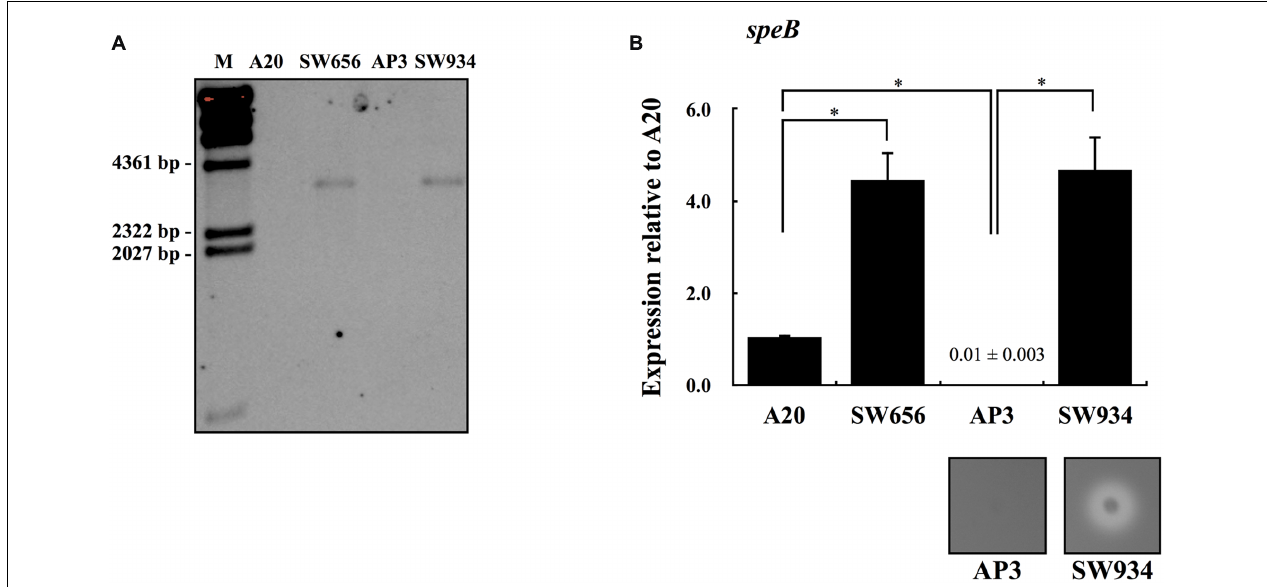
FIGURE 1 | The expression of speB in wild type A20 strain, covS mutant AP3, and their covR isogenic mutants. (A) Southern blot analysis for A20, AP3, and their covR isogenic mutants SW656 and SW934. Genomic DNAs were extracted and digested with Eco RV. The interruption of the covR gene by a chloramphenicol (Cm) cassette was detected by the Cm probe. M, λ / Hin dIII DNA marker. The expression of speB in (B) A20, SW656, AP3, and SW934 in the stationary phase of growth. Group A Streptococcus (GAS) strains were cultured in broths for 7 h and RNAs were extracted for quantitative PCR (qPCR) analysis. Biological replicate experiments were performed using four independent RNA preparations in duplicate. The expression of speB was normalized to the gyrA . ∗ p < 0.05. The lower panel in (B) shows the protease activity of AP3 and SW934. Bacteria were cultured in the 3% skim-milk agar for 12 − 16 h, and the appearance of a clear zone around bacterial colony is considered protease